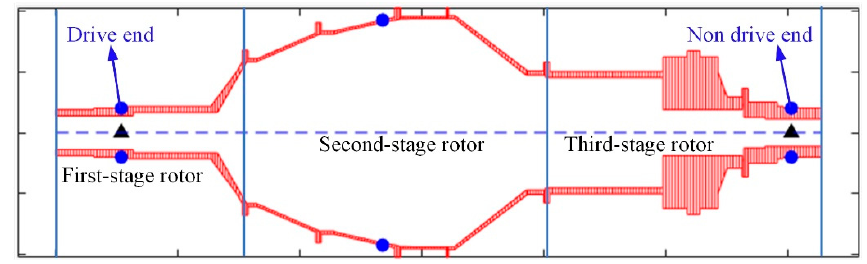
Figure 2. Simulation model of rotor vibration. Table 1. Simulation parameters of rotary parts